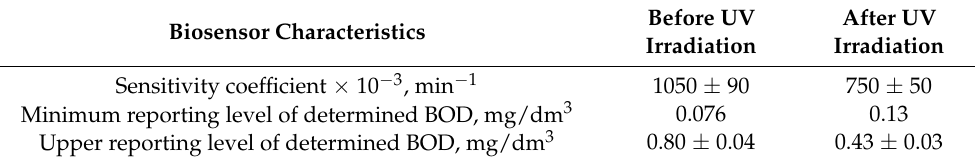
Table 2. Characteristics of a biosensor based on P. yeei immobilized in a sol–gel matrix before and after UV